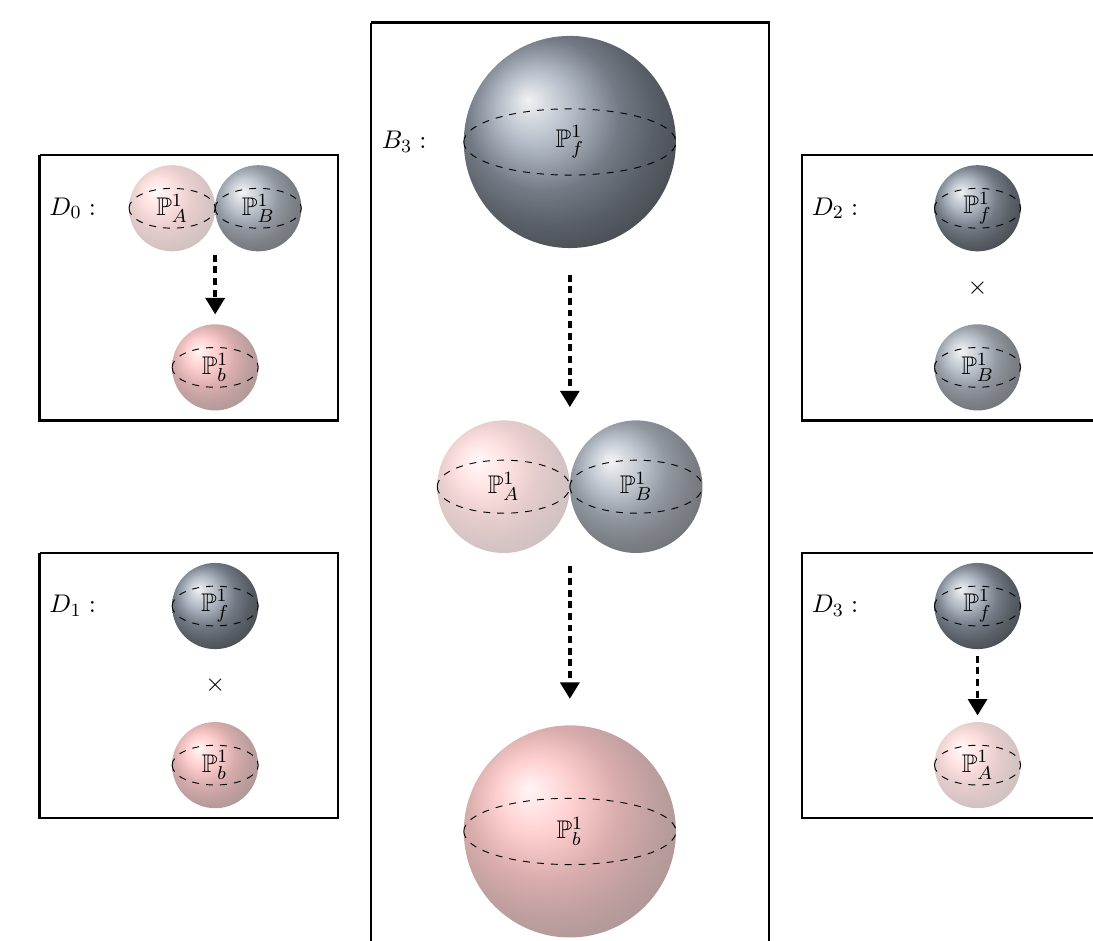
Figure 4. We show the base B 3 = P 1 → Bl ( F n ) (center) for u = t = 0 as well as the topology of the divisors D i , i = 0 , . . . , 3